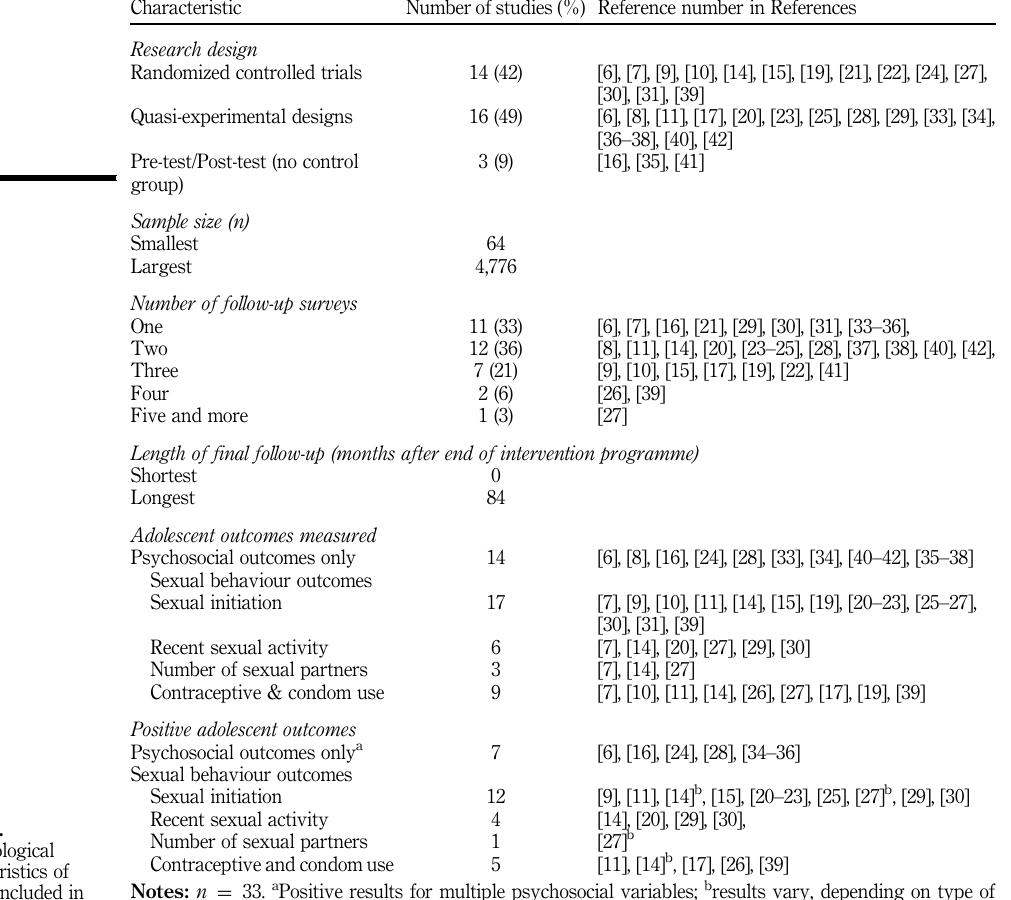
Table I. Methodological characteristics of studies included in this